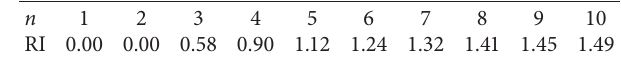
Table 1: Random index (RI)